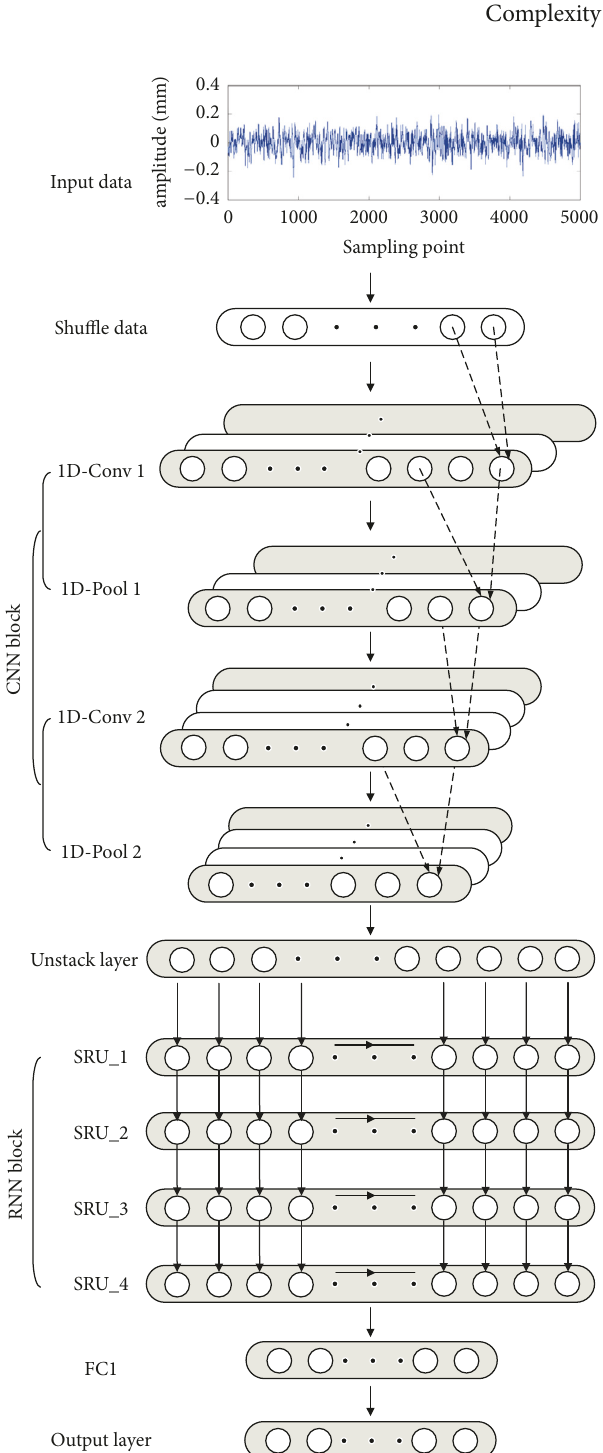
Figure 5: Framework of the proposed